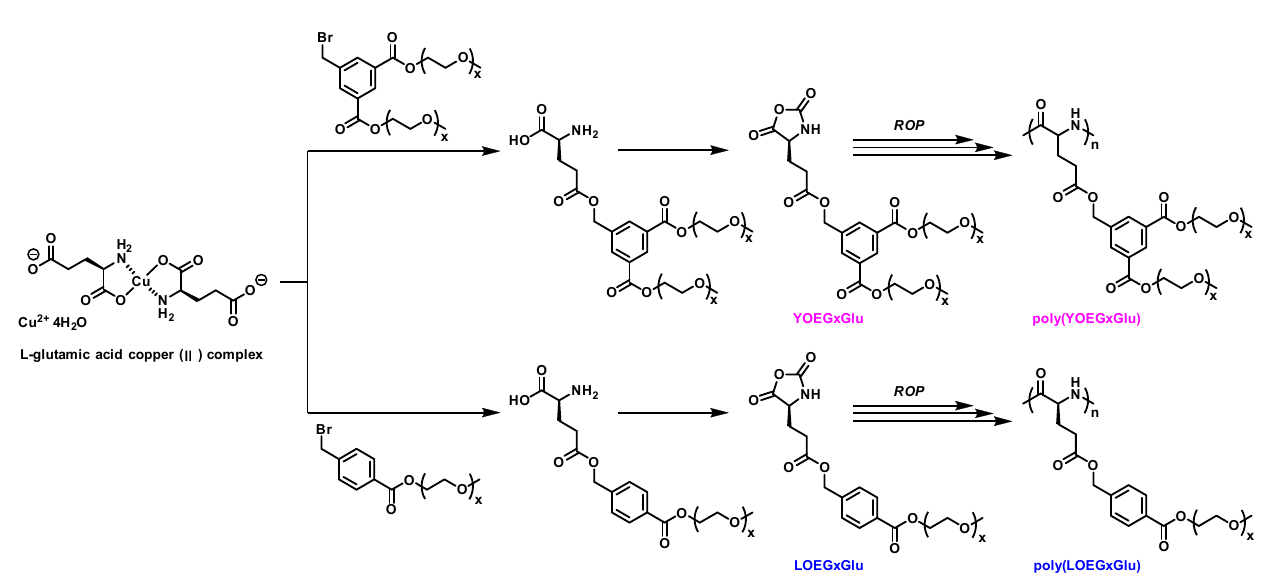
Figure 11. Synthesis of linear and Y-shaped OEGylated poly(YOEG x Glu)s and poly(LOEG x Glu)s via NCA polymerization. Reproduced with permission [27]. Copyright 2019, American Chemical Society.